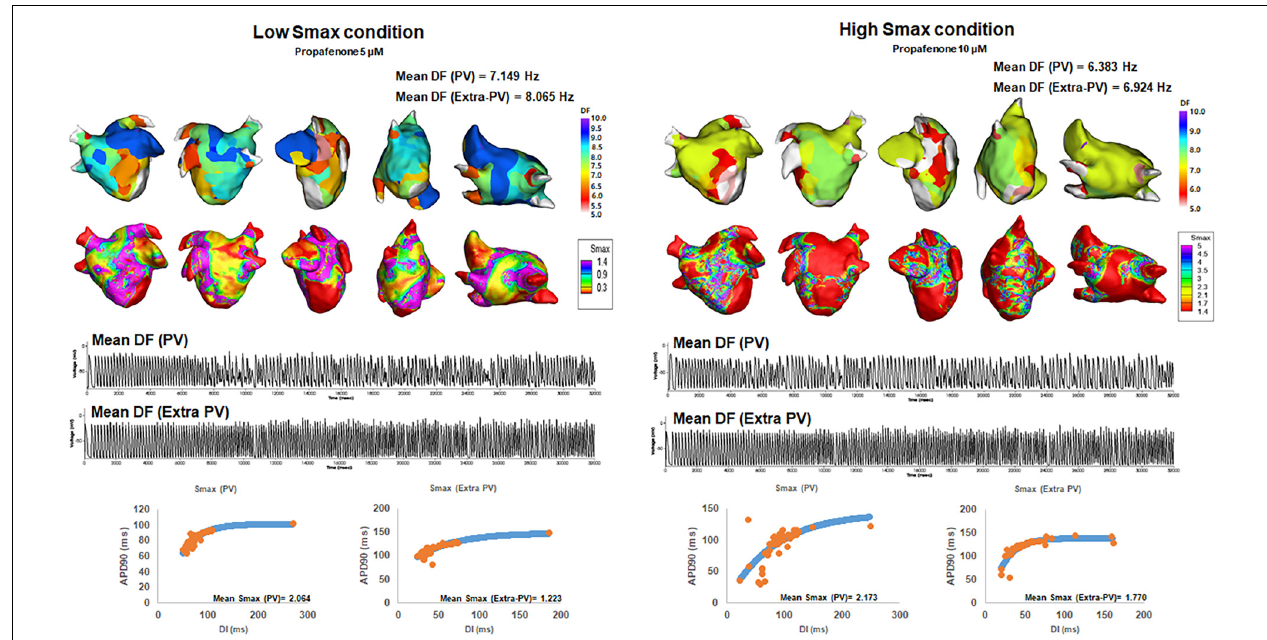
FIGURE 3 | Changes in the dominant frequency (DF) during a high and low Smax. The 3D DF map indicated that the mean DF was inversely related to the mean Smax. Regional voltage changes in pulmonary vein (PV) and extra-PV areas were demonstrated in electrograms.